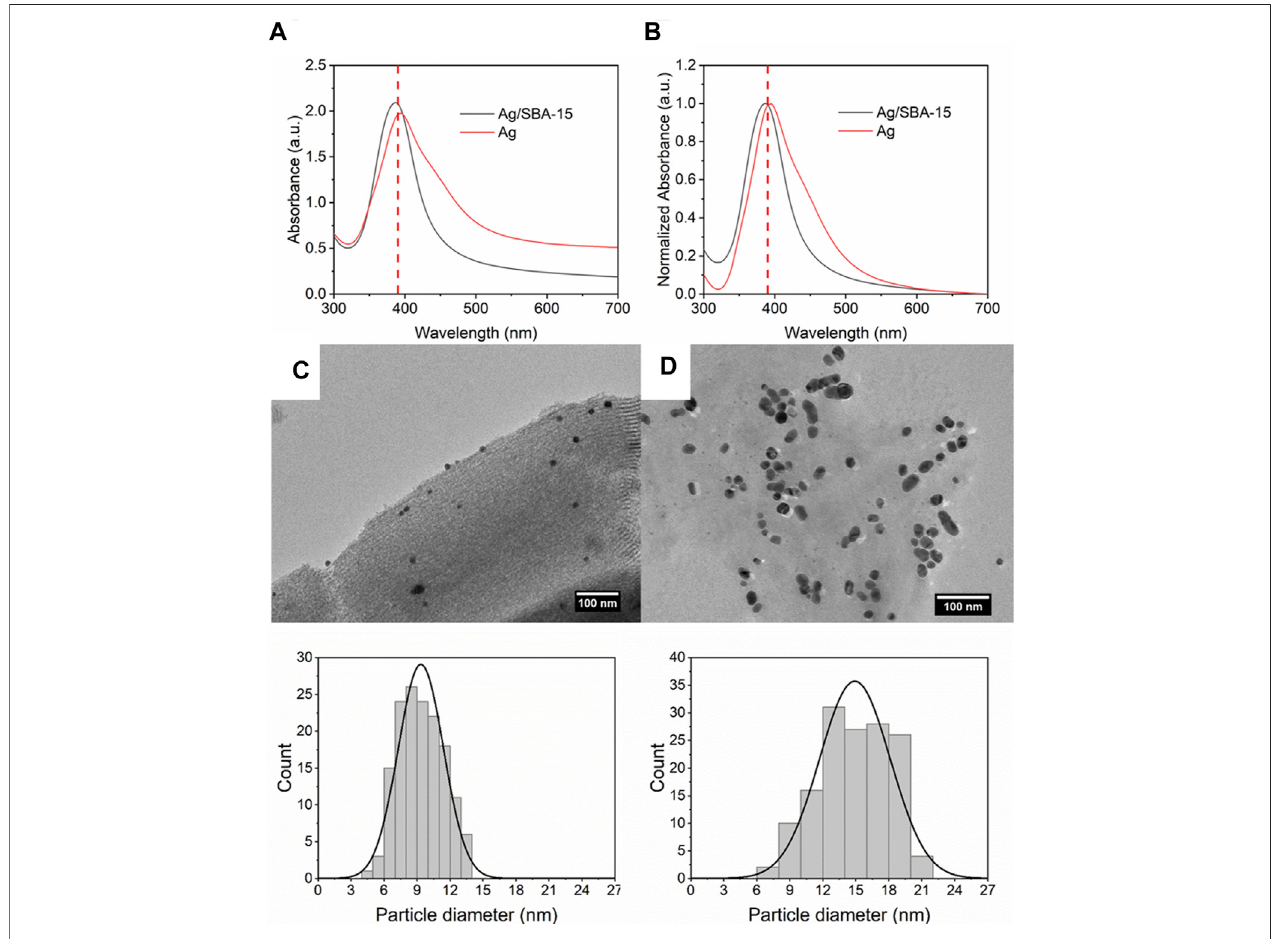
FIGURE 3 | (A) UV-vis absorbance spectra and (B) normalized absorbance spectra for Ag/SBA-15 and Ag nanoparticle synthesized in a coiled fl ow inverter microreactor. TEM images and sizedistributionofsilvernanoparticlessynthesized (C) withSBA-15 support (9.35 ± 2.06 nm), and (D) without SBA-15 support (14.91 ± 3.22